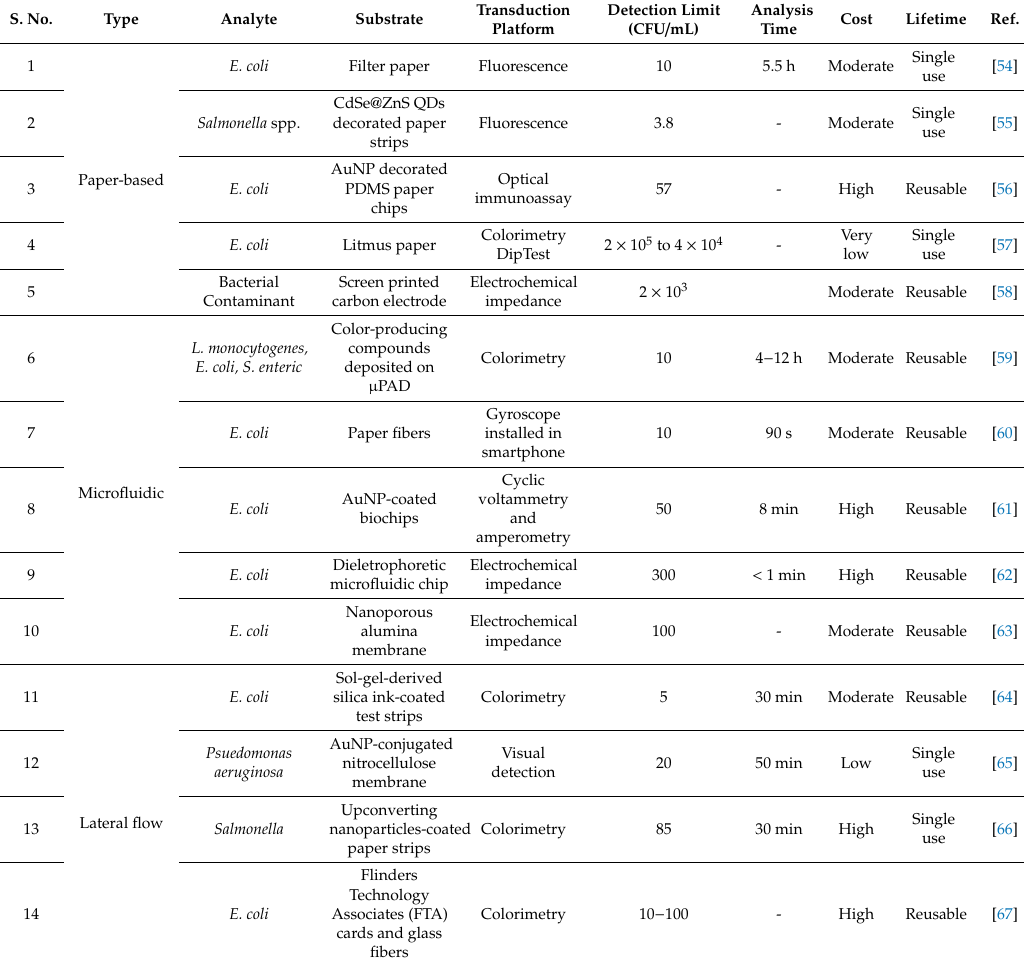
Table 1. List of various platforms available for on-site detection of biological contaminants. S.